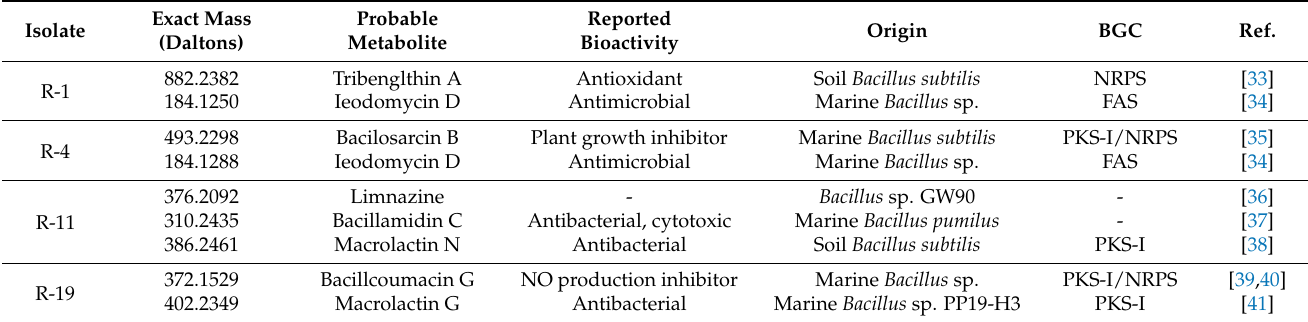
Table 4. The probable metabolite for each exact mass detected in the metabolic extracts of the active isolated strains from the Natural Products